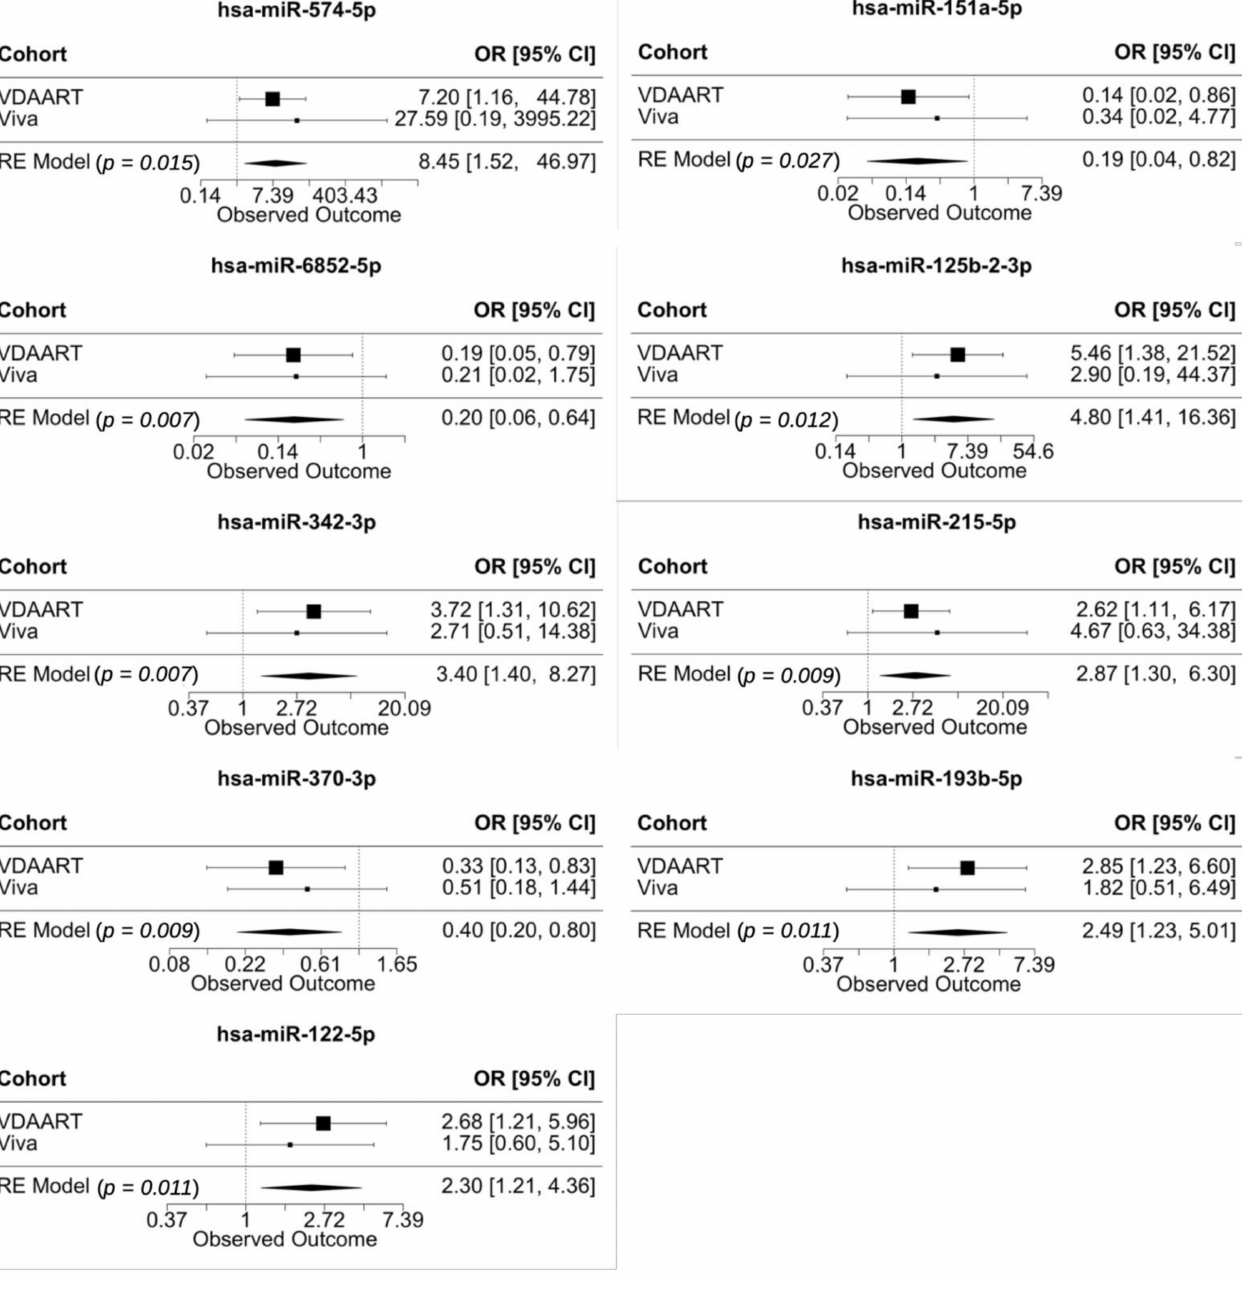
Figure 1. Meta-Analysis of 9 validated miRNAs. MiRNAs are ordered from left top to right bottom in terms of the effect